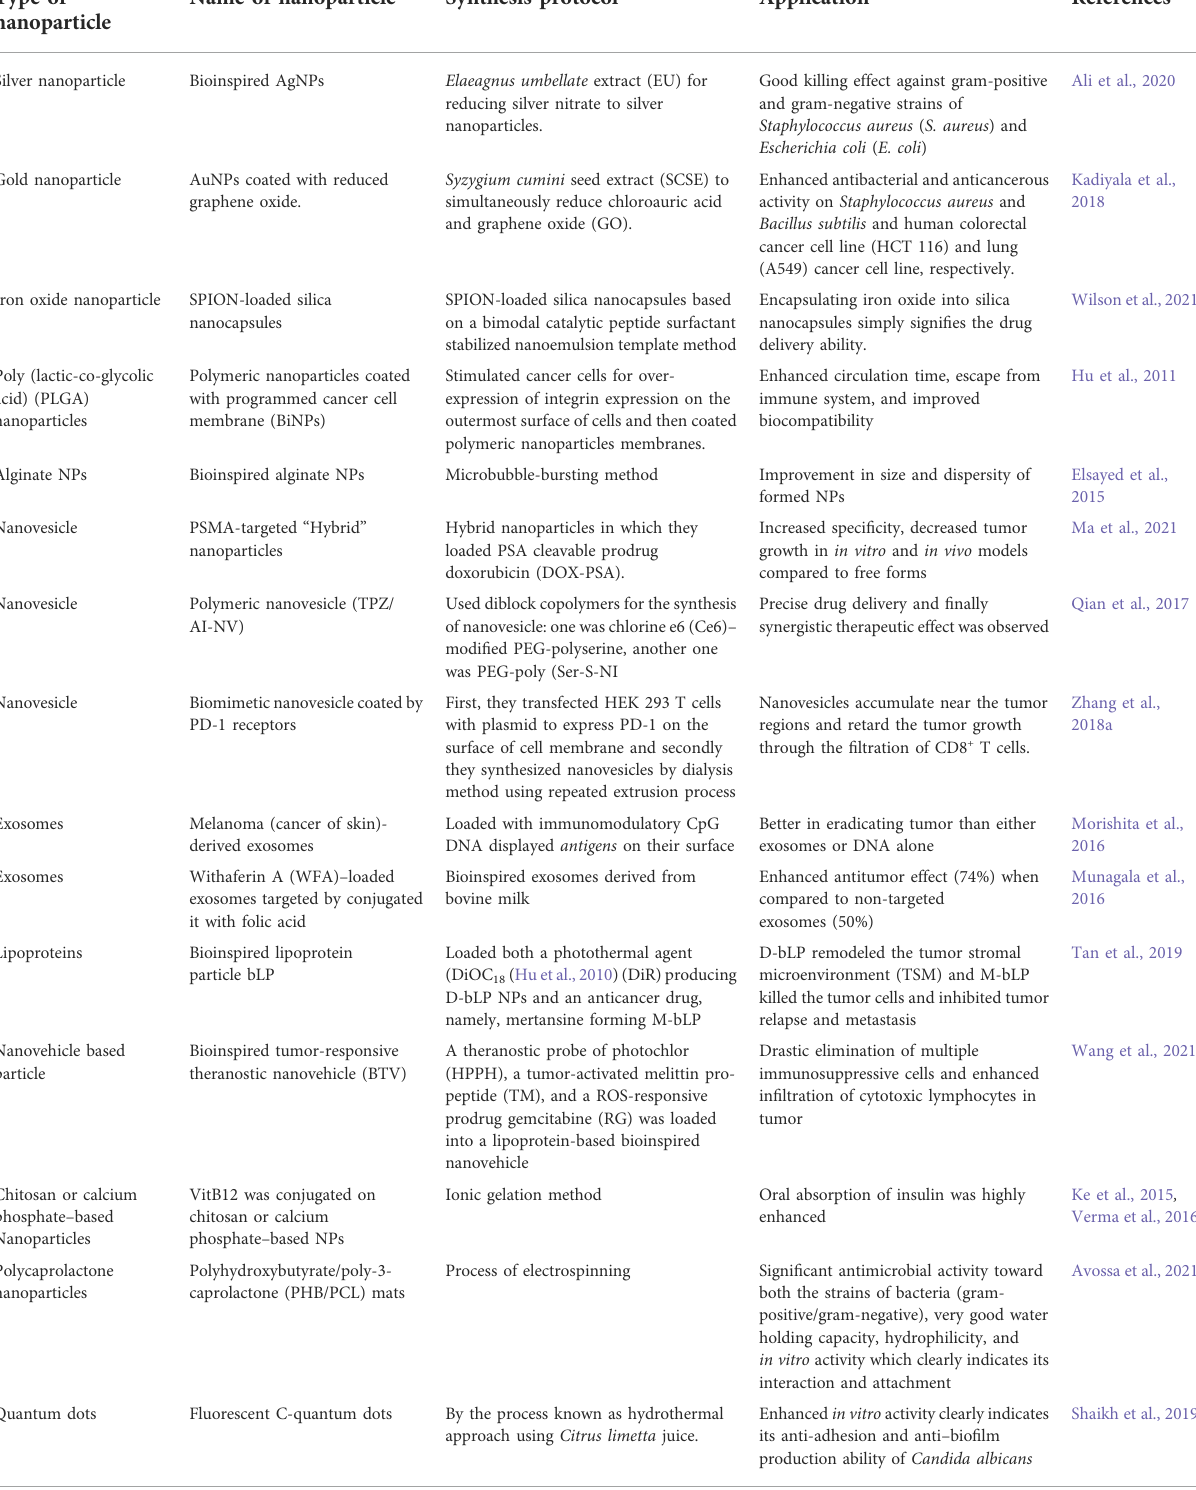
TABLE 1 Summarizes the nanoparticles formed by bioinspired technology discussed in the review